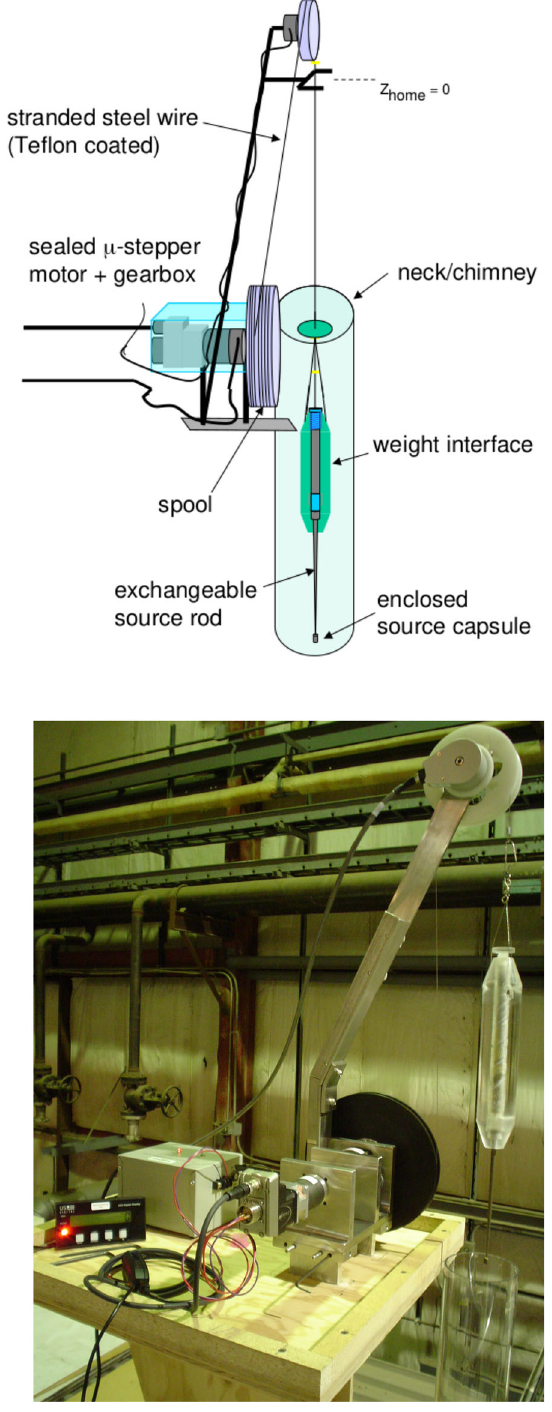
Fig. 24 On the top the basic components of the z-axis system are illus- trated. The picture on the bottom shows the far detector system on a test bench before installation in the glove box one as used for the GB). Outside the GC flange, the flexible Teflon tubing ran within black vinyl tubes to assure light tightness.